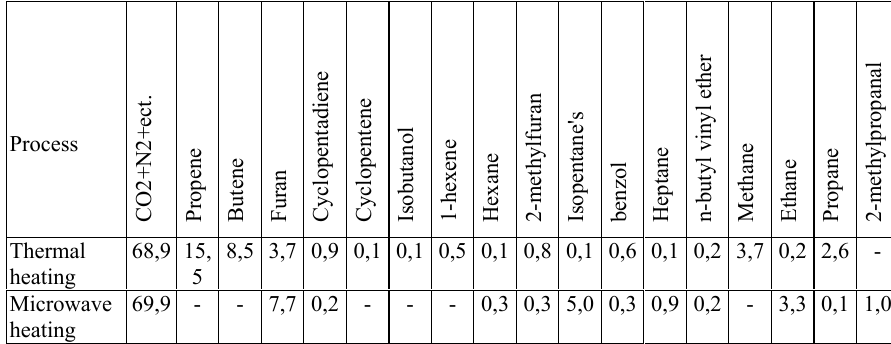
Table 1. Chromatography-mass spectrometry analysis of pyrolytic gases.